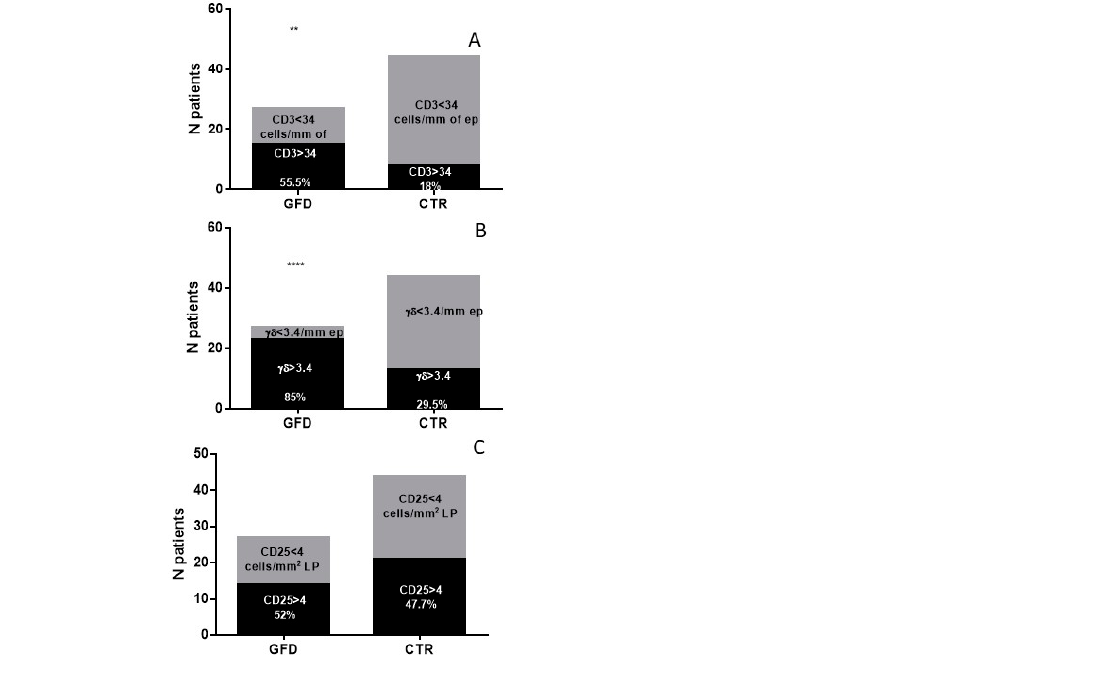
Figure 3. Percentage of patients with altered immunohistochemical parameters. ( A ) patients with altered CD3+ cells/mm of intestinal epithelium. ( B ) patients with altered TCR γδ + cells/mm of intestinal epithelium. ( C ) patients with altered CD25+ cells/mm 2 of intestinal lamina propria. N: number; GFD: gluten free diet; CTR: controls. *: level of statistical significance; ** means p < 0.005, **** p < 0.00005.